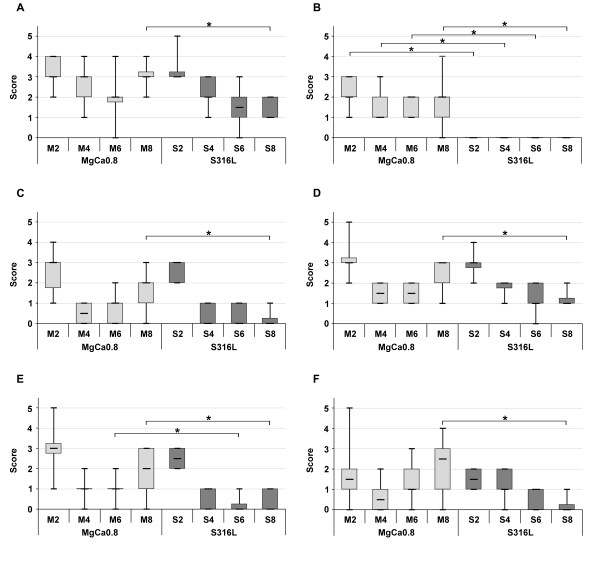
Boxplots of the histological evaluation of cranial tibial muscle cross sections after implantation of MgCa0.8 (light grey boxplots) and S316L (dark grey boxplots) for two, four, six and eight weeks (two weeks is represented as M2 for MgCa0.8 and as S2 for S316L, four weeks as M4 for MgCa0.8 and S4 for S316L, etc.). The boxplots are representing the amount of (A) periimplant fibrosis, (B) tissue cavities, (C) necrosis, (D) macrophages, (E) giant cells and (F) heterophil granulocytes. Non parametrical tests (Mann-Whitney-Tests) were calculated to determine differences between the implant materials. Stars represent significant difference, which was defined as p < 0.05.